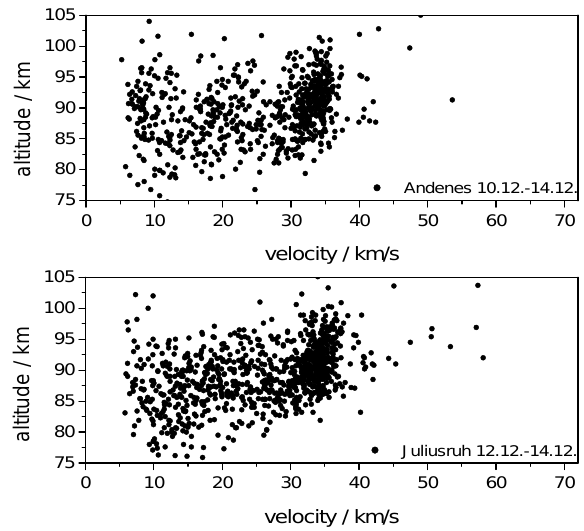
Fig. 6. Meteor altitude versus velocity distribution for the Andenes and Juliusruh MR during the peak period of the Geminid